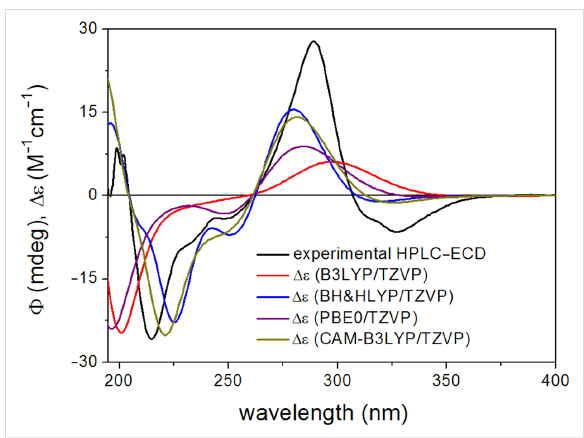
Figure 4: Experimental HPLC–ECD spectrum of ( R )-naringenin (( R )- 1 ) compared with the Boltzmann-weighted ECD spectra computed for the CAM-B3LYP/TZVP PCM/CHCl 3 low-energy conformers of ( R )- 1 at various